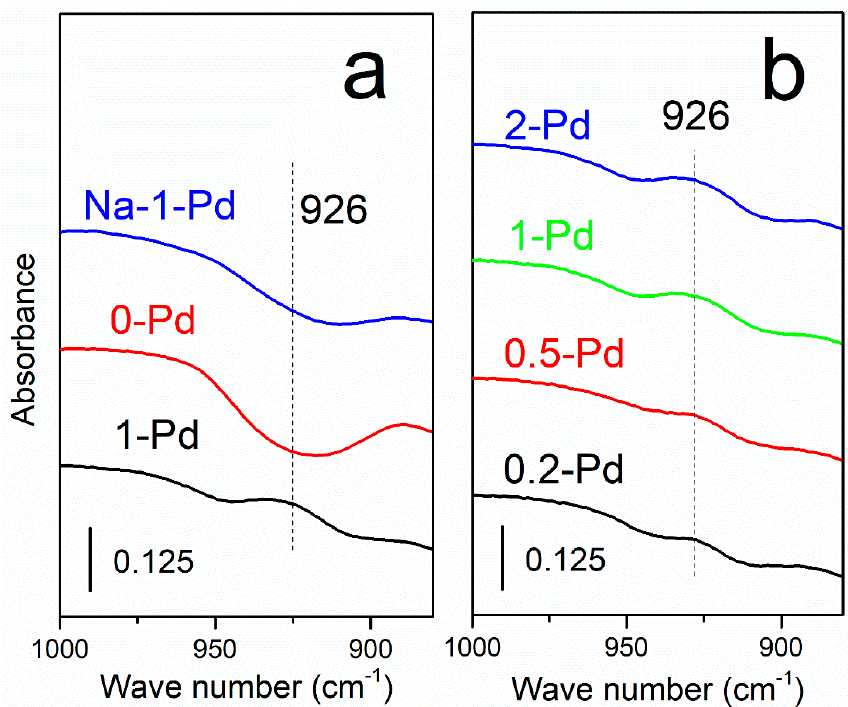
Figure 1. ( a ) Ex-situ FTIR spectra of 0-Pd, 1-Pd, Na-1-Pd; ( b ) Ex-situ FTIR spectra of 2-Pd, 1-Pd, 0.5-Pd, 0.2-Pd (Temperature: 200 °C; Flow: N 2 , 1 L/min)